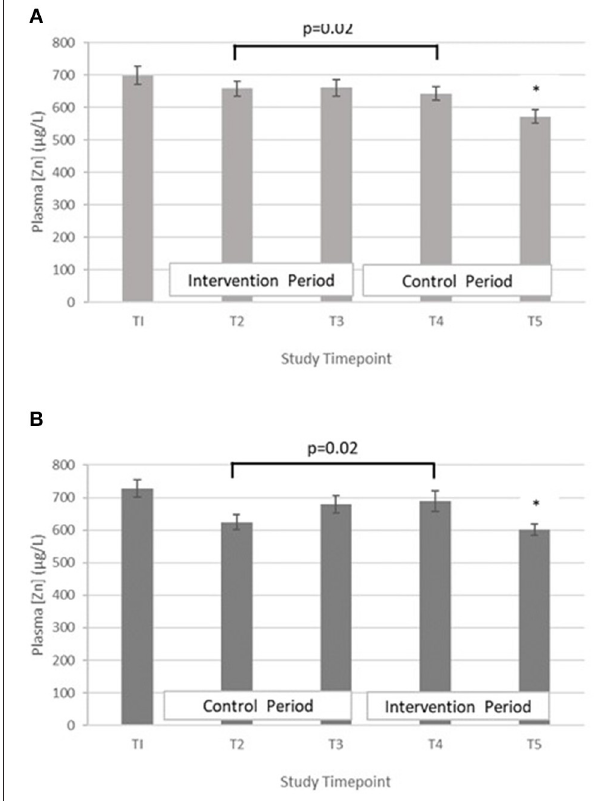
FIGURE 2 | (A) Plasma zinc concentration measured in Group A at baseline (T1), week 4 of period 1 (T2), week 8 of period 1 (T3), week 4 of period 2 (T4) and week 8 of period 2 (T5). Bars indicate estimated marginal means with standard error. *Estimated marginal mean is significantly lower than at all other timepoints, p < 0.01. (B) Plasma zinc concentration measured in Group B at baseline (T1), week 4 of period 1 (T2), week 8 of period 1 (T3), week 4 of period 2 (T4) and week 8 of period 2 (T5). Bars indicate estimated marginal means with standard error. *Estimated marginal mean is significantly lower than at all other timepoints, p < 0.01.